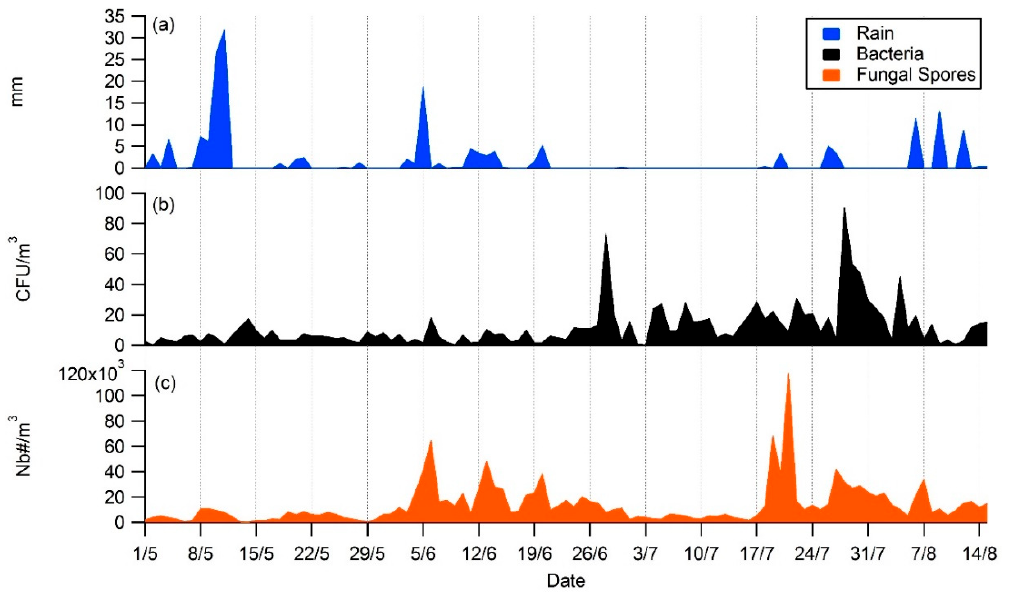
Figure 10. Effect of a rain events ( a ), blue color in mm on atmospheric cultivable bacterial concentrations ( b ),black color in CFU/m 3 and fungal spores concentrations ( c ), orange color in NB#/m 3 during summer 2019 at Saclay.